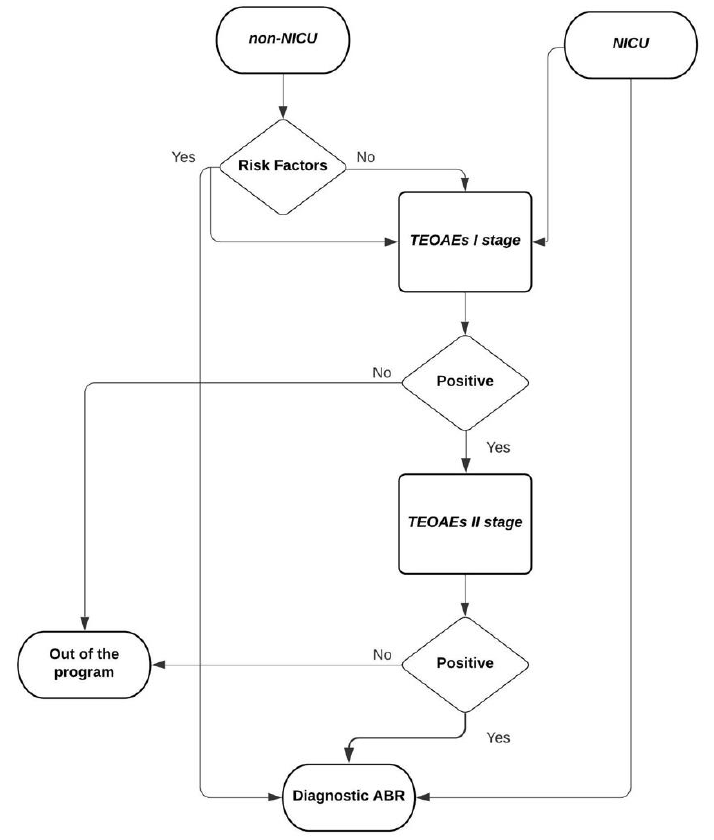
Figure 1. Flowchart of our screening protocol.